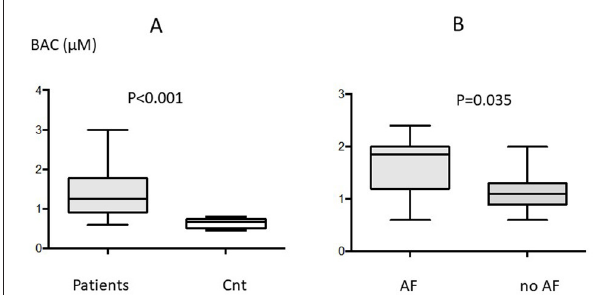
FIGURE 1 | Blood adenosine concentration (BAC) in the whole population ( n = 39) of patients (A) and in controls; and (B) in patients with ( n = 15) or without ( n = 24) perioperative atrial fibrillation (AF). Box indicates mean ± SD and vertical lines indicate the range.